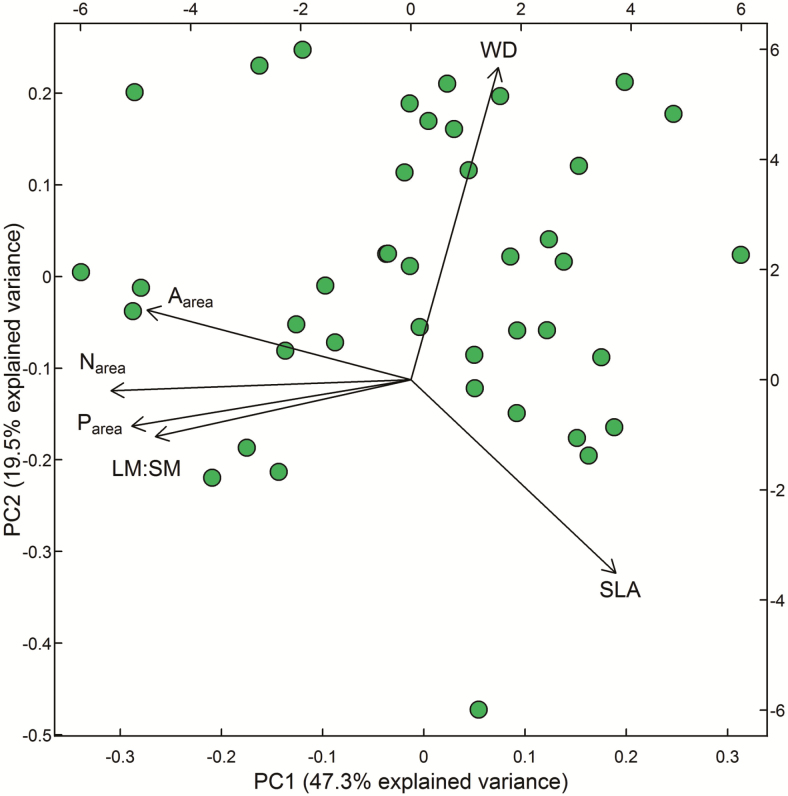
A principal component analysis showing the two main axes of variability in traits amongst 41 rainforest species. Traits are log-transformed specific leaf area (SLA), log-transformed light-saturated photosynthetic rate (Aarea), log-transformed leaf nitrogen (Narea), log-transformed leaf phosphorus (Parea), trunk wood density (WD) and log-transformed branch-scale ratio of leaf mass:sapwood mass estimated at a standard branch cross-sectional area of 100 mm2 (LM:SM). Each data point represents a species mean. Principal component analysis axis 1 and 2 account for 66.7 % of the variation in the data. Length of vectors represents the contribution of a trait to the ordination.